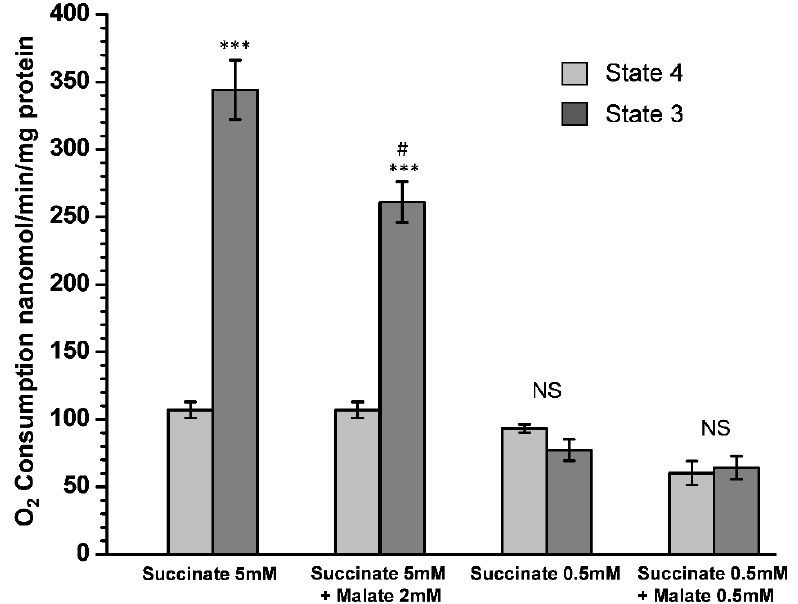
Figure 2. Kidney mitochondria do not possess the intrinsic inhibition of succinate dehydrogenase. The light gray columns represent O 2 consumption rate in State 4, and the dark gray columns represent the respiration rates in State 3 initiated by adding 150 µM ADP. Incubation conditions as in Figure 1. Substrates: succinate and malate concentrations, as shown in the figure. Statistics: *** — p < 0.001; # — p < 0.001, a comparison with the State 3 succinate 5 mM. The number of experiments (separate isolations of kidney mitochondria) for each substrate: Succinate 5 mM, n = 7; succinate 5 mM + malate 2 mM, n = 5; succinate 0.5 mM, n = 6; succinate 0.5 mM + malate 0.5 mM, n = 4.